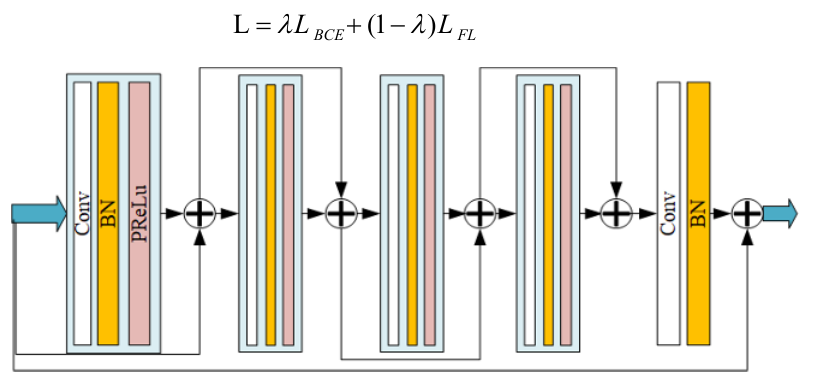
Fig. 4. Structure of RRM Fig.5. Segmentation diagrams of